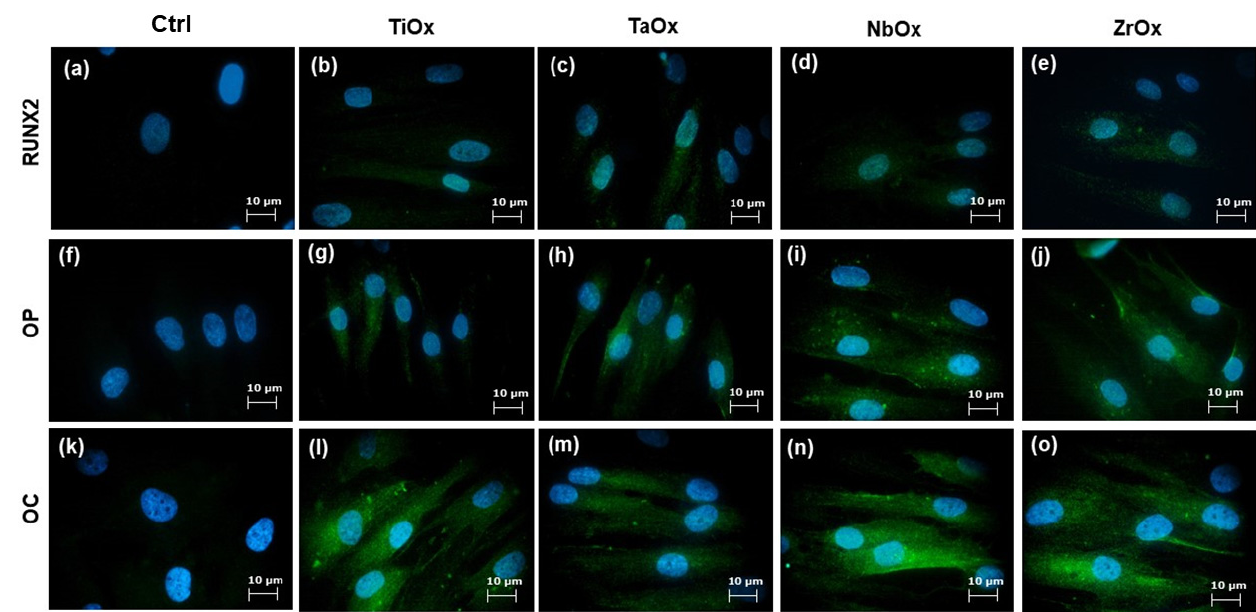
Figure 9. RUNX2 ( a – e ), OP ( f – j ) and OC ( k – o ) cellular expression characterized by IF assays in BM-MSC cultured on the coatings. In green, positive expression of the corresponding osteogenic marker is observed, while in blue, cell nuclei stained with Hoechst are observed. Ctrl corresponds to cells cultured on standard tissue culture plates.